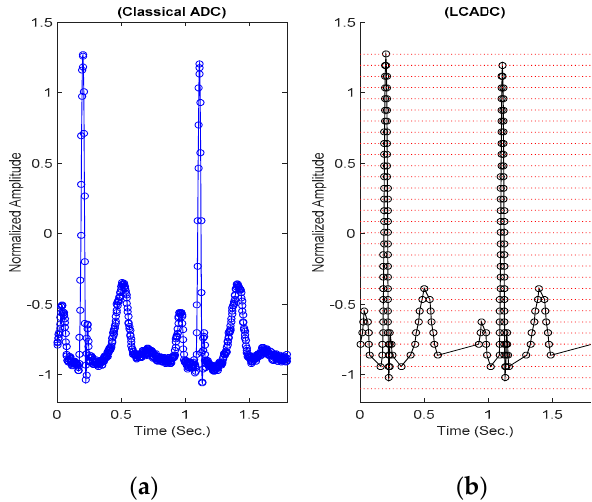
Figure 7. The pre-segmented ECG signal, acquired with an 11-bit resolution conventional ADC ( a ) and acquired with a 5-bit resolution LCADC ( b ). Table 1. Summary of the reference filters bank parameters.